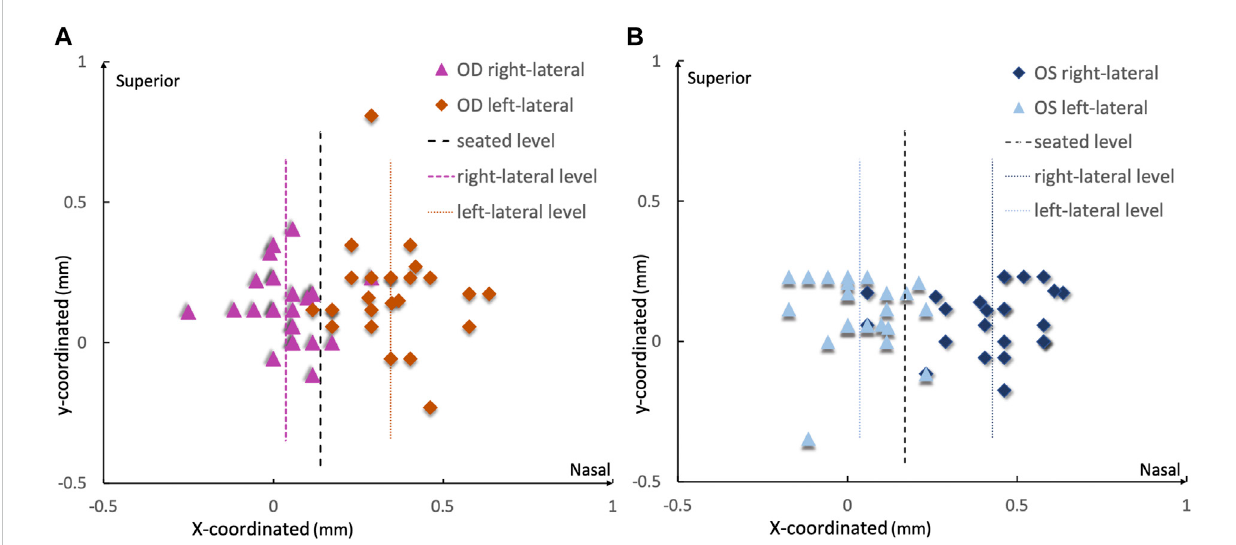
FIGURE 4 The pupil center shift at lateral position [ (A) for right eyes and (B) for left eyes]. The coordinates (0, 0) represent the limbus center. When changed from seated to right lateral, pupil centers of both eyes shift to the right, which means nasal for left eyes and temporal for right eyes. Similarly, when switchedfromseatedtoleftlateral,pupilcentersofbotheyesshifttotheleft,whichmeansnasalforrighteyesandtemporalforlefteyes.Thedottedlines represent the average shifts at each position.